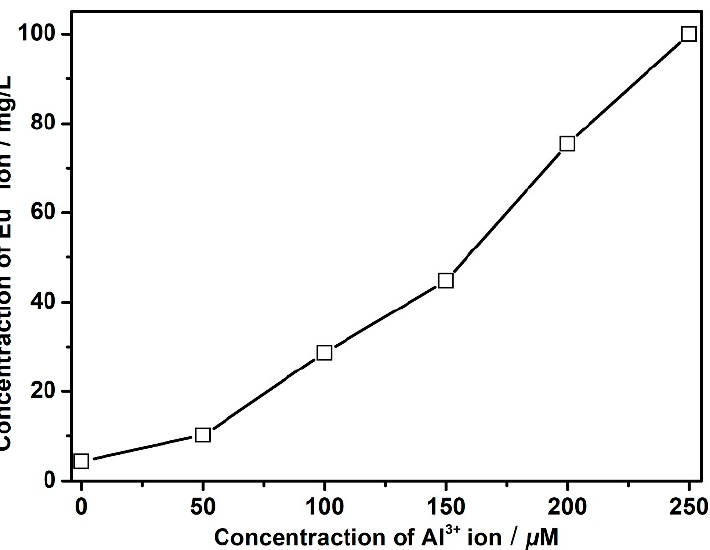
Figure 9. The concentrations of Eu III ions in the filtrate of Eu(tta) 3 bpdc-SiO 2 @mTiO 2 upon the addition of different contents of Al 3+ ions.